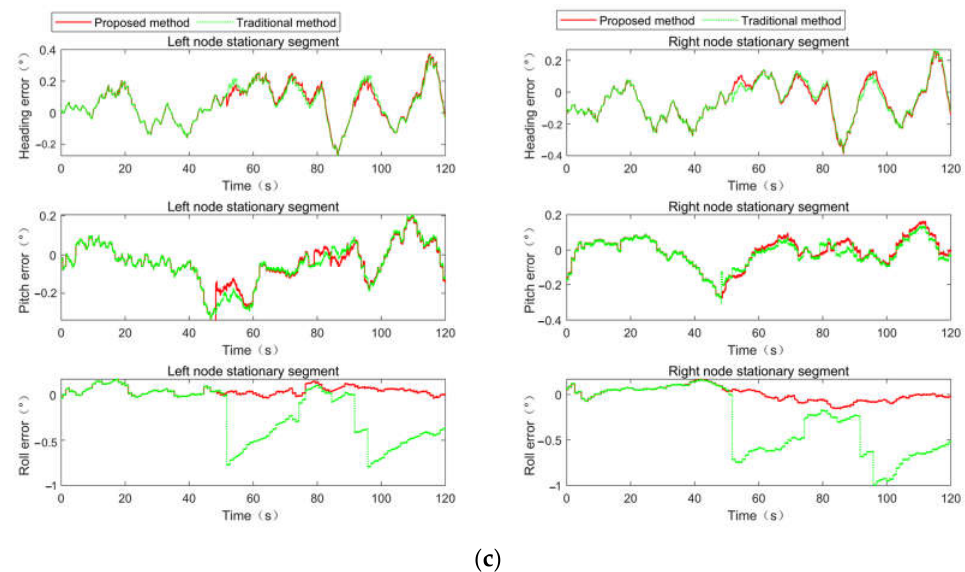
Figure 9. Comparison of filtering results. ( a ) Position comparison of filtering results; ( b ) velocity comparison of filtering results; ( c ) attitude comparison of filtering results.